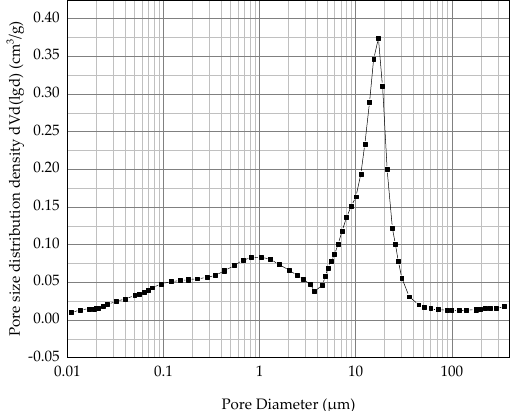
Figure 18. Pore size distribution density curve of soil sample 3.